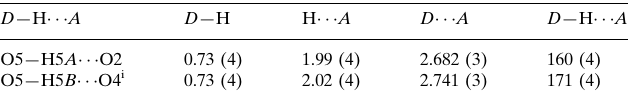
Hydrogen-bond geometry (A˚ , (cid:2)